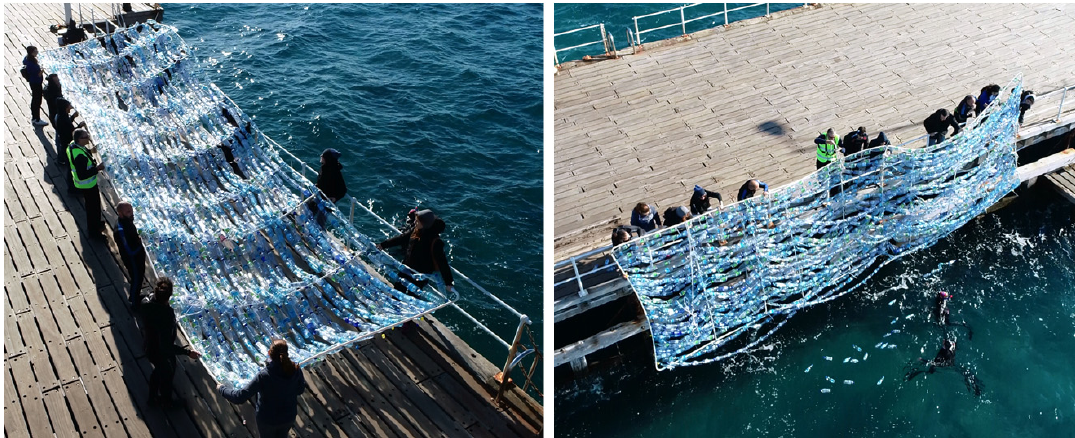
Figure 2. Plastic litter “target” being lowered into the sea at Limassol Old Port. Kyriacos